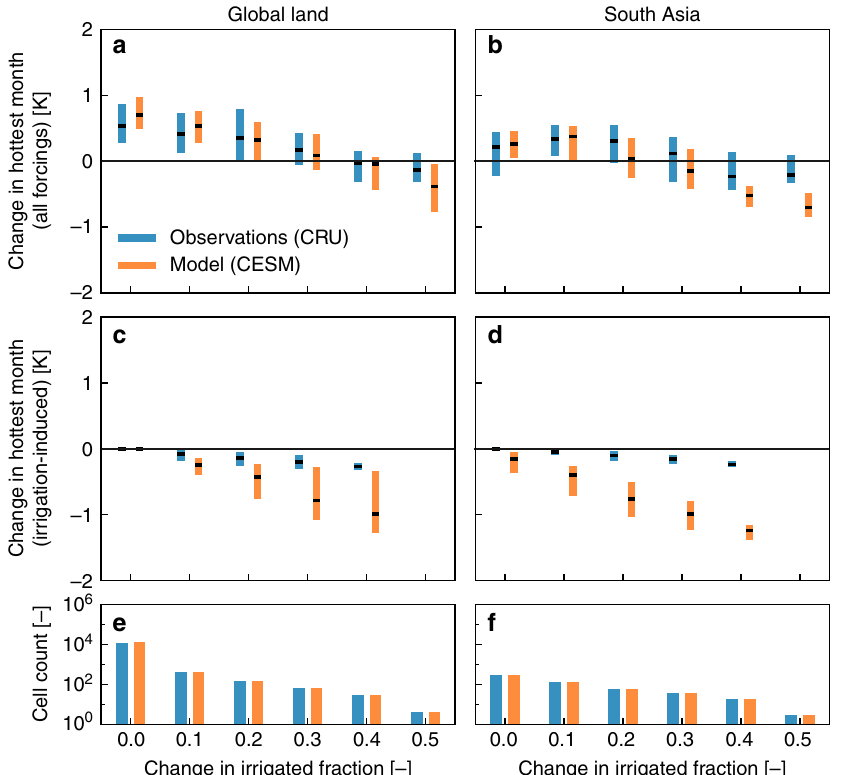
, c , d ) change in average daily Fig. 1 Observed warming rates affected by irrigation. Boxplots of the total ( Δ TXm , a , b ) and irrigation-induced ( Δ TXm irr maximum temperature during the hottest month of the year for global land ( a , c ) and South Asia ( b , d ) between 1901 and 1930 and 1981 and 2010. Results were binned by the change in grid cell fraction equipped for irrigation (hereafter referred to as irrigated fraction f ) between both periods. Cell counts per irr bin for Δ TXm are indicated in e , f . Blue bars represent results from the CRU observational data, orange bars show results from the CESM global climate irr simulations. Boxplots indicate the spatial distribution (centre line: median; box limits: upper and lower quartiles; whiskers and outliers: not shown) and are only plotted for bins containing (cid:1) 5 pixels. Note that most grid cells with f 0 : 5 for the global land are situated in South irr >